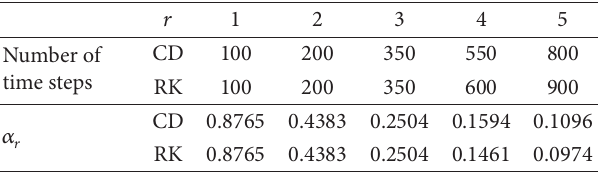
Table 1: Stability conditions for the CD and the RK time discretiza- tion